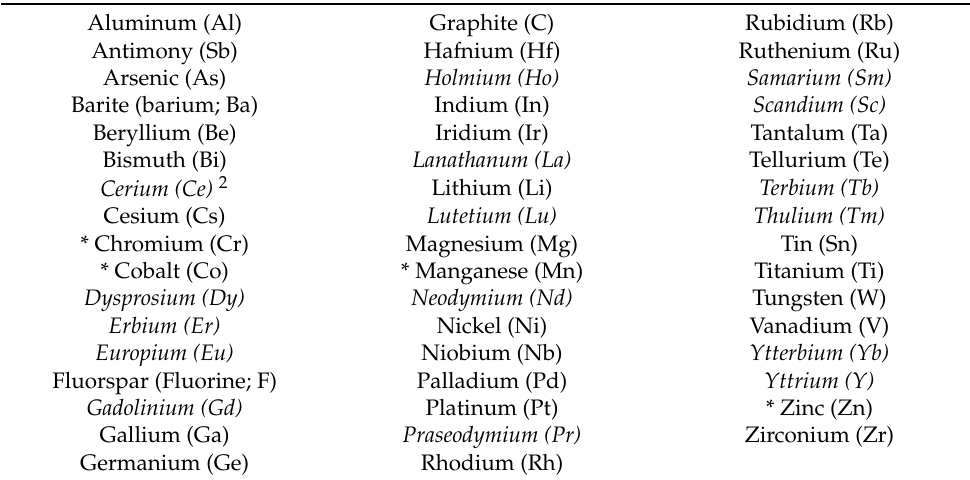
Table 1. The U.S. Geological Survey 2022 list of critical minerals 1 . Aluminum (Al) Graphite